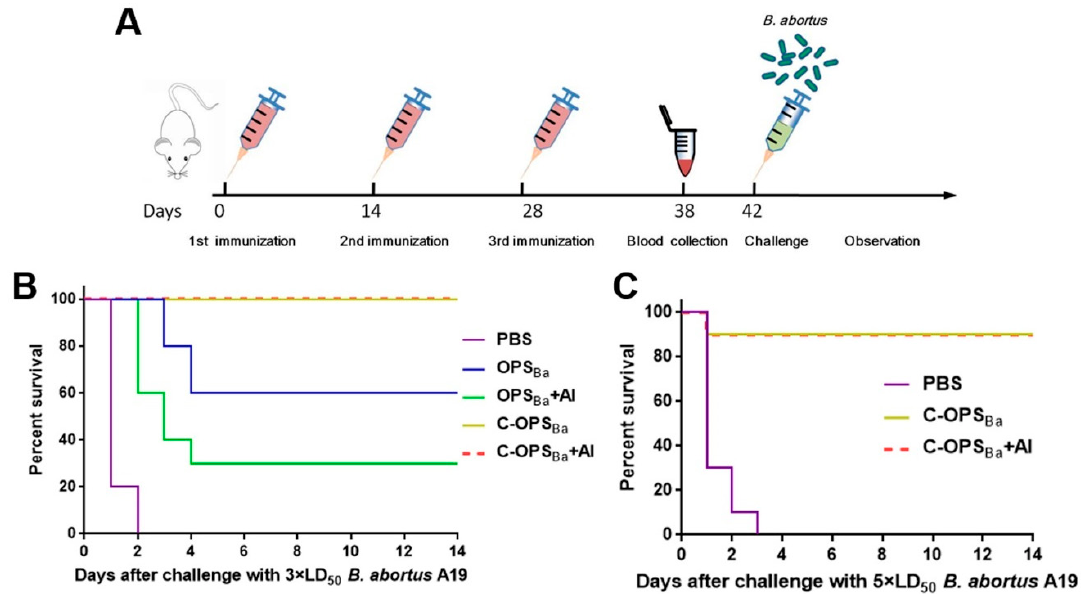
Figure 4. Survival of BALB/c mice after challenge with a lethal dose of B. abortus A19. Mice were challenged 2 weeks after final immunization by intraperitoneal injection with different doses of A19 and survival was monitored. ( A ) Schematic diagram of the challenge experiment. ( B ) Mice were immunized with PBS, OPS Ba , OPS Ba +Al, C-OPS Ba or C-OPS Ba +Al and challenged with ~1.54 × 10 8 CFU/mouse (3 × LD 50 ) of A19 ( n = 10). ( C ) Mice were immunized with C-OPS Ba , C-OPS Ba +Al or PBS then challenged with approximately 2.51 × 10 8 CFU/mouse (5 × LD 50 ) of A19 ( n = 10).